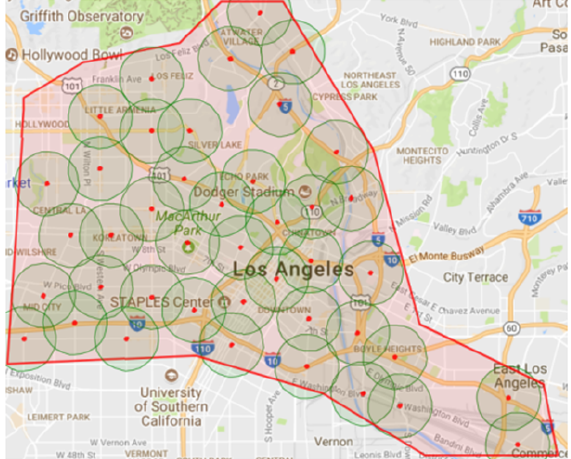
Figure 3. Los Angeles Downtown Road